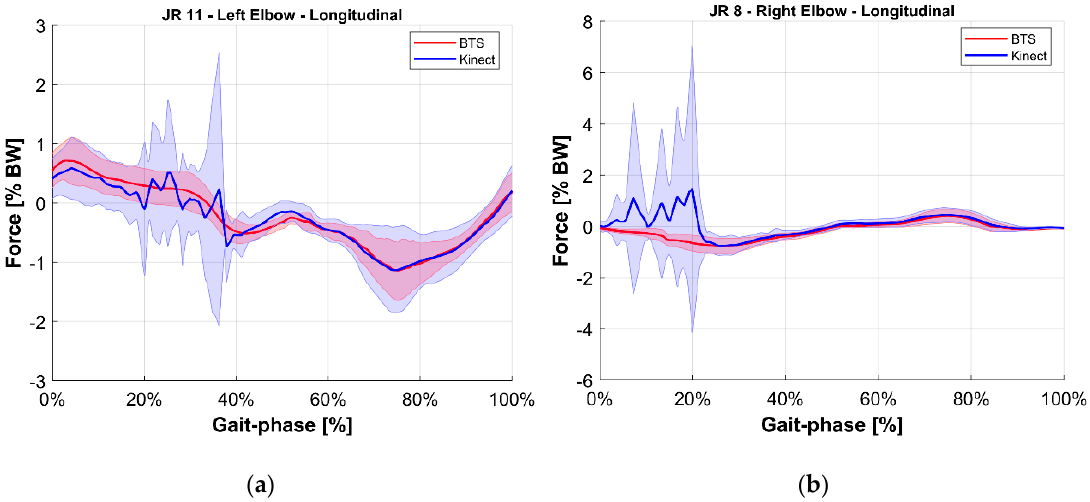
Figure 12. Lateral internal reaction force at the shoulder joint. Blue indicates the M-Kinect assessment. Red indicates the reference using BTS marker-based mocap. Bold lines represent the average of all tests. The shaded areas represent their standard deviation. ( a ) Left joint. ( b ) Right joint. The subject was right-dominant.